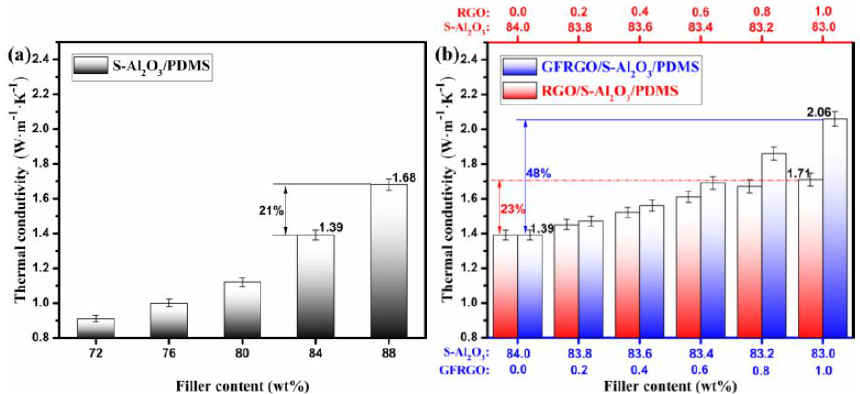
Figure 5. Thermal conductivity of ( a ) S-Al 2 O 3 /PDMS composites and ( b ) GFRGO/S-Al 2 O 3 /PDMS and RGO/S-Al 2 O 3 /PDMS composites with different filler contents.